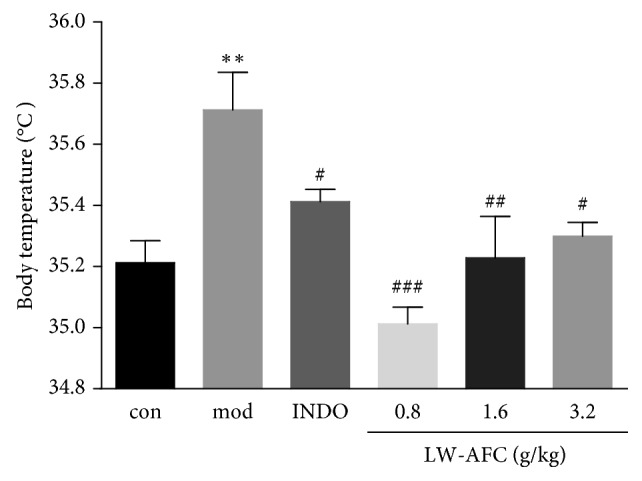
Effect of LW-AFC on body temperature in LPS-treated mice. ∗∗p < 0.01vs. con and Student's t-test; ###p < 0.001, ##p < 0.01, and #p < 0.05vs. mod, one-way ANOVA, and Dunnett's test, mean ± SD, n = 8. con, control; mod, model; INDO, indomethacin.